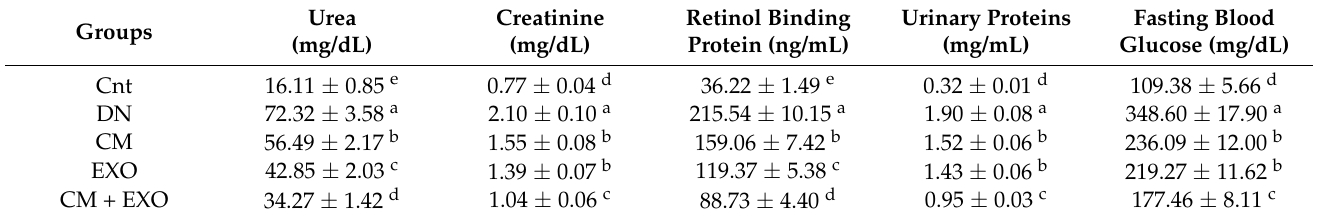
Table 2. Effect of camel milk and/or its EXOs on levels of renal damage parameters and fasting blood